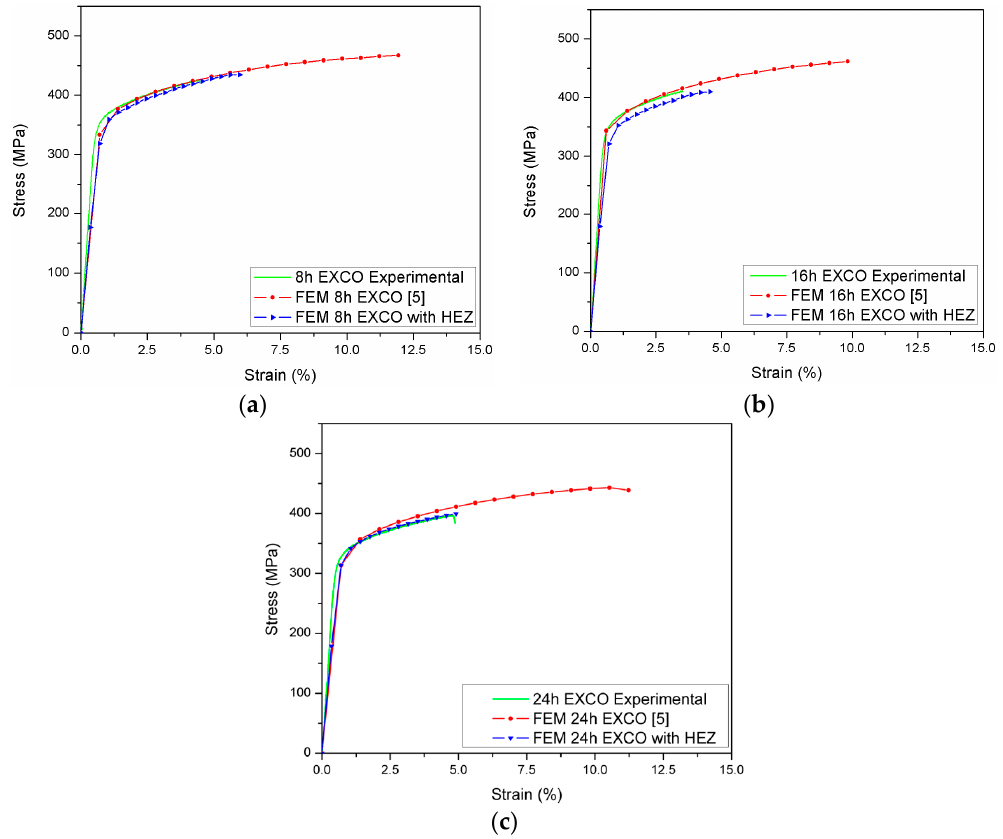
Figure 11. Stress-strain curves of the corroded material, comprising the experimental results and numerical simulations, accounting for purely geometrical features of corrosion damage and the insertion of the HEZs after ( a ) 8 h, ( b ) 16 h and ( c ) 24 h of exposure. Larger discrepancies between the experimental and numerical results can be observed for